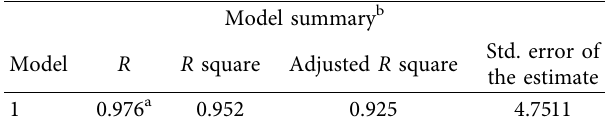
Table 4: Model summary and R values.